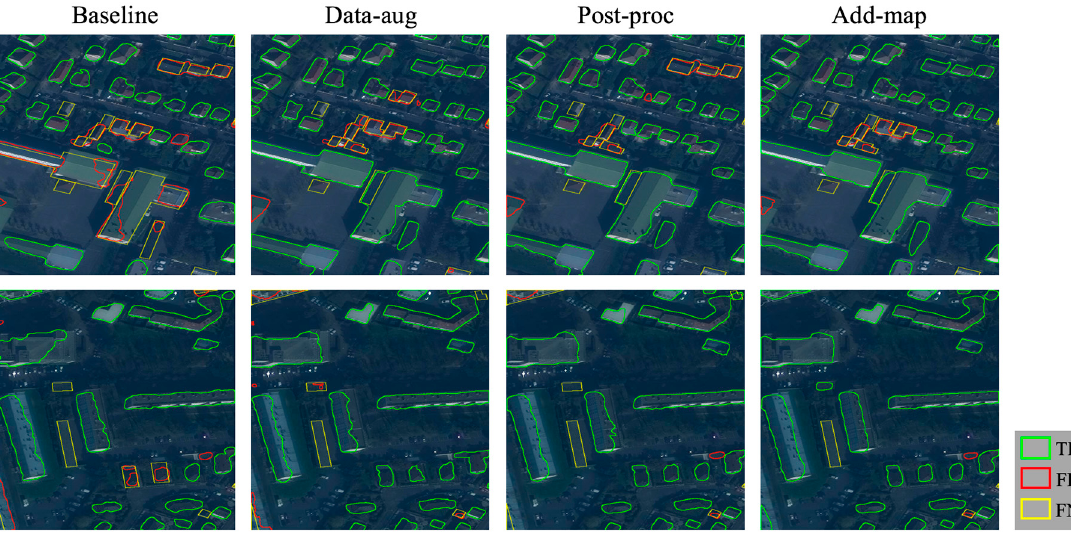
Figure 8. Examples of building extraction results for Shanghai using different strategies.